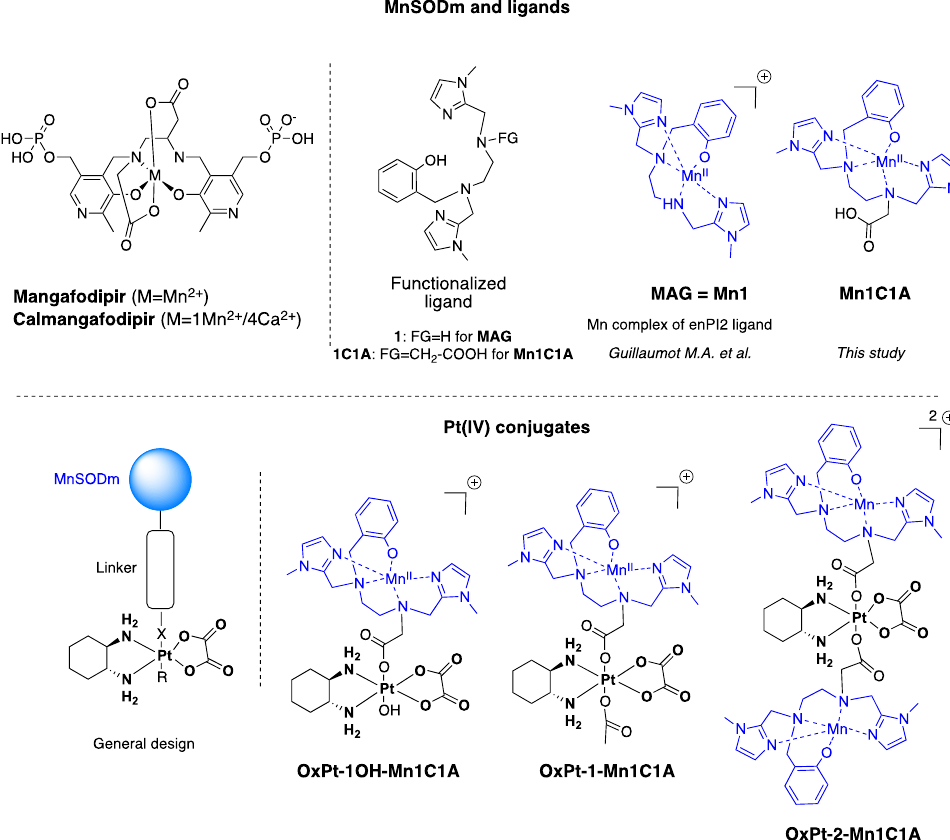
Figure 1. Structure of MnSOD mimics and Pt(IV) conjugates developed in this study. OxPt-x-Mn1C1A conjugates are Pt(IV) complexes combining oxaliplatin and Mn1C1A complex on axial position (MAG (Mn1) in association with oxaliplatin see